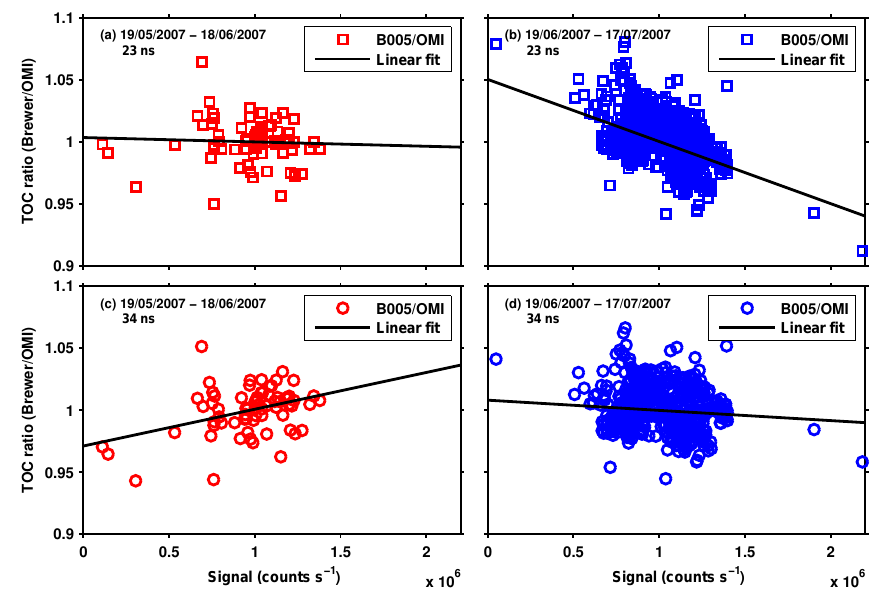
Figure 9. Ratio of TOC derived from B005 for different DT values and OMI, as a function of the Brewer measured signal at slit-mask position 5